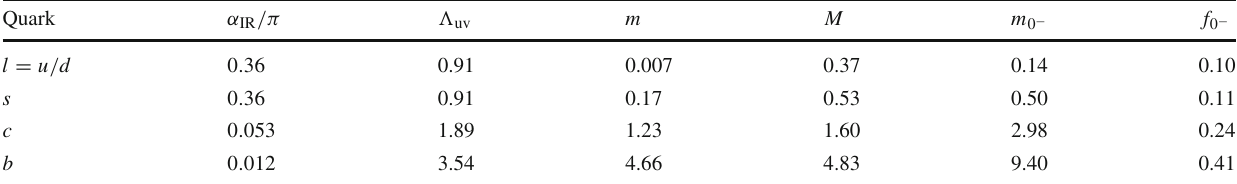
Table 1 The SCI is defined by three parameters. The infrared cutoff (confinement scale) is fixed: (cid:9) ir = 0 . 24GeV. The ultraviolet cutoff, (cid:9) α uv , and running coupling, IR are chosen in tandem so as to ensure a good description of pseudoscalar meson masses and leptonic decay constants, with the results listed here. m is the current-mass of the iden-